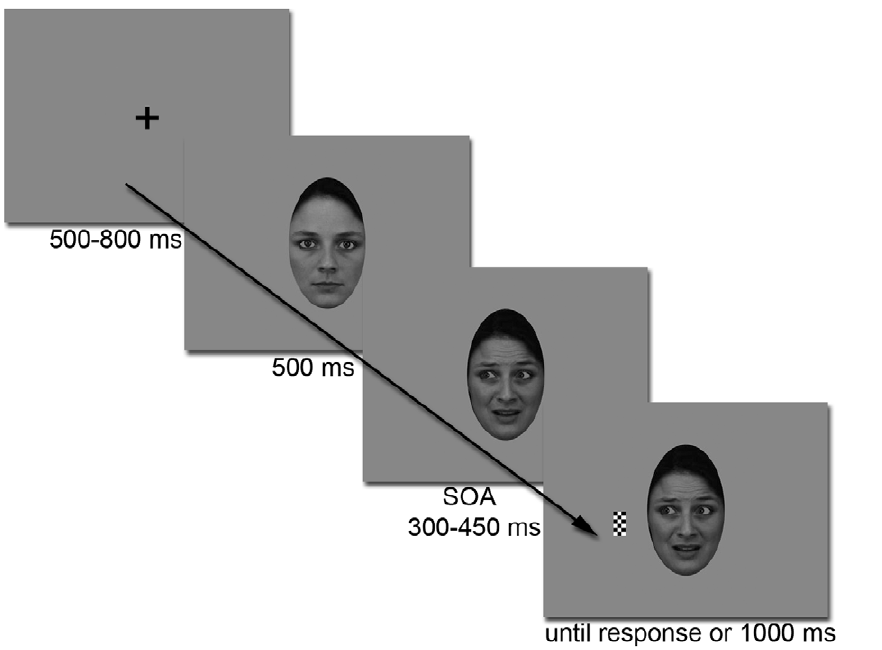
Figure 1. Example of a fear congruent trial. Each trial started with the presentation of a fixation cross in the center of the screen for 500 to 800 ms. A neutral face gazing at the participant was then presented for 500 ms. Then, the emotion of the face changed to either a fearful (here) or a happy expression, and the eyes were simultaneously averted either to the right or to the left side of the screen, or remained straight ahead. After a variable SOA of 300 to 450 ms, the target checkerboard appeared either on the right or on the left side of the screen. The subject’s task was to respond to the target as fast as possible. The target and the face stayed on screen until the subject’s response or during 1 s maximum.